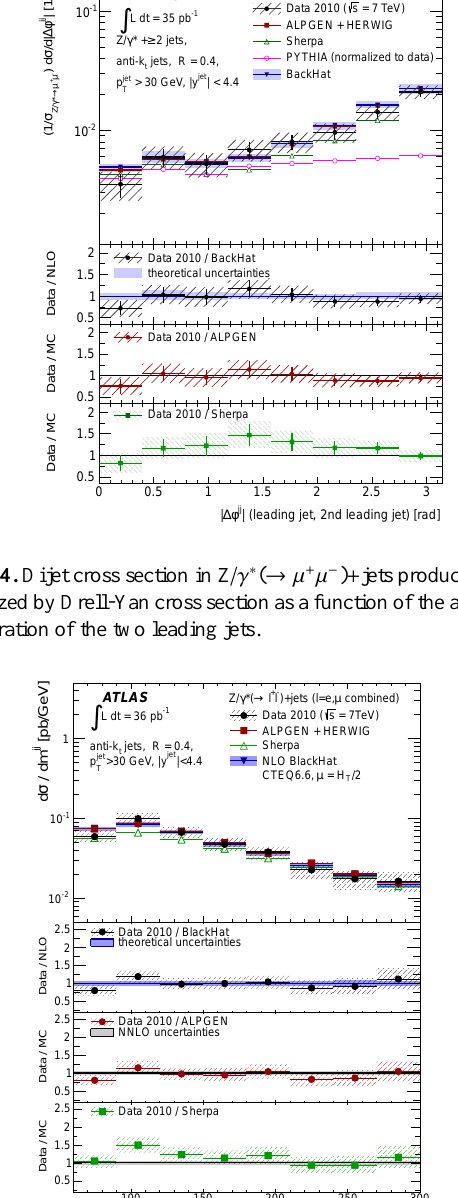
e + e − ) + jets produc- → Fig. 5. Dijet cross section in Z / γ ∗ ( function of the invariant mass of the two leading